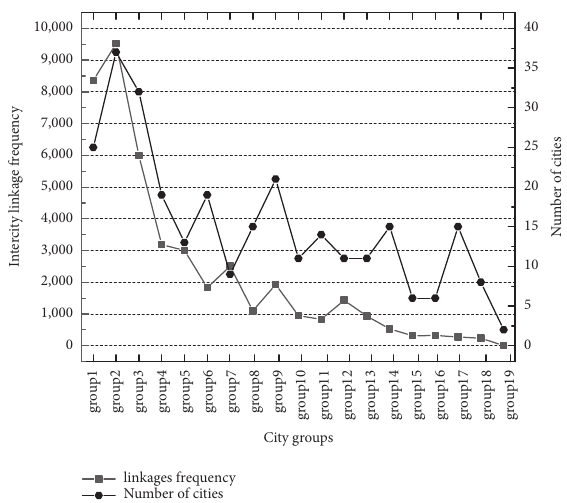
Figure 2: Structural attributes of city groups in